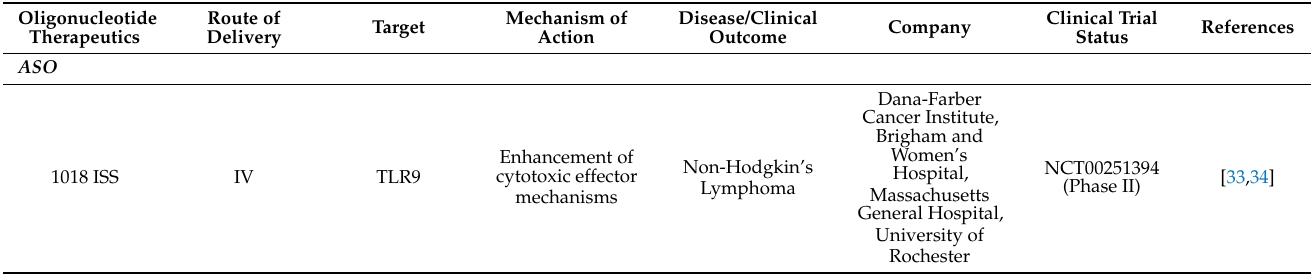
Table 2. RNA therapeutics in clinical